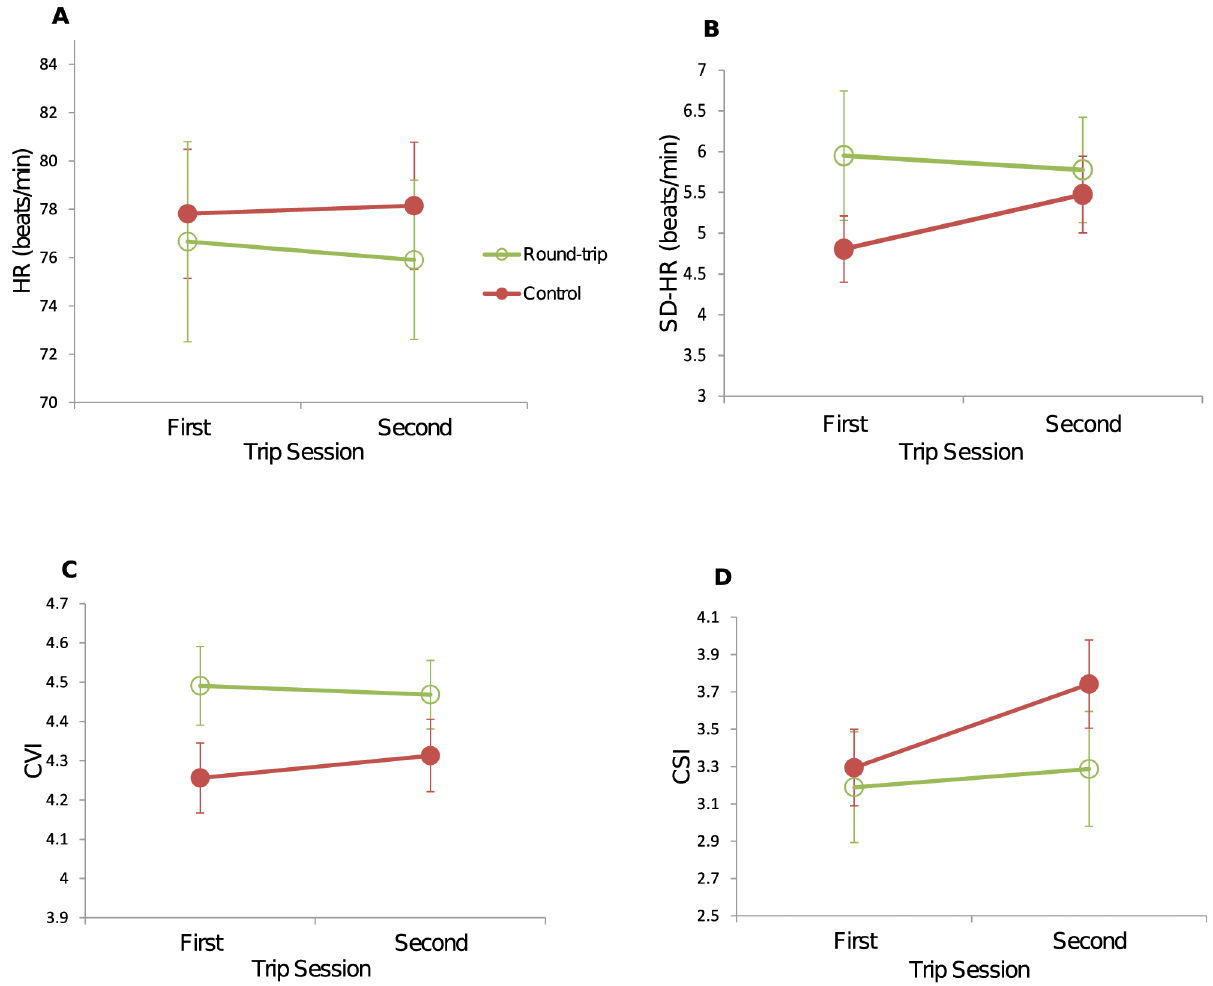
Fig 3. Physiological indices. (A) Mean HR in each condition, (B) mean SD-HR in each condition, (C) mean CVI in each condition and (D) mean CSI in each condition, calculated across participants. Values are means ± 1SE. HR, heart rate; SD-HR, standard deviation of heart rate; CVI, cardiac vagal index; CSI, cardiac sympathetic